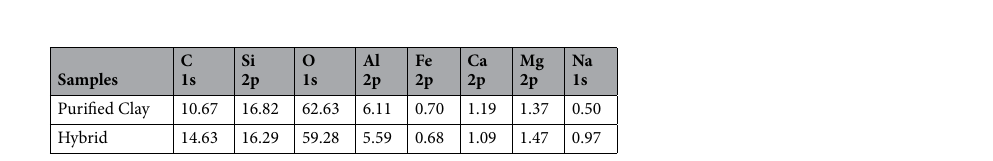
Table 7. Atomic concentrations of starting clay before and after the adsorption process of EO.